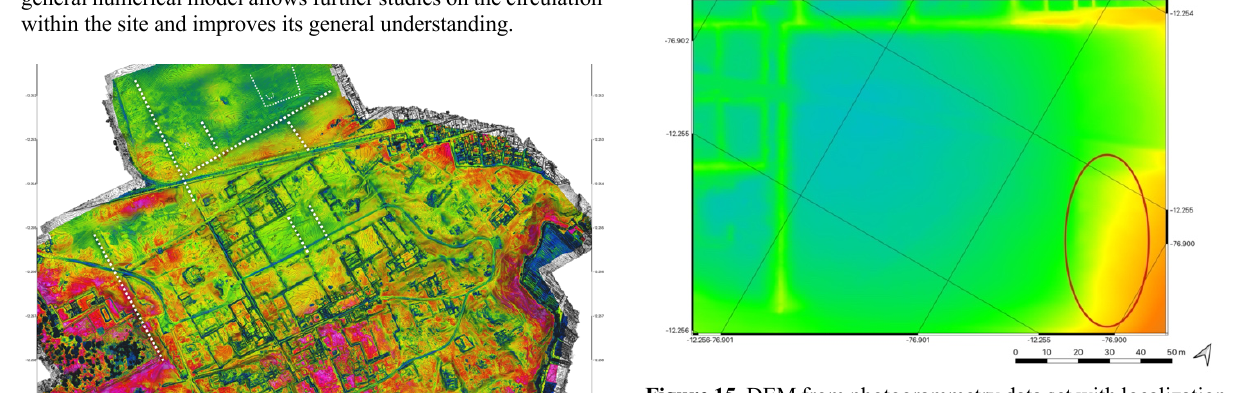
Figure 15 . DEM from photogrammetry data set with localization of a slight level